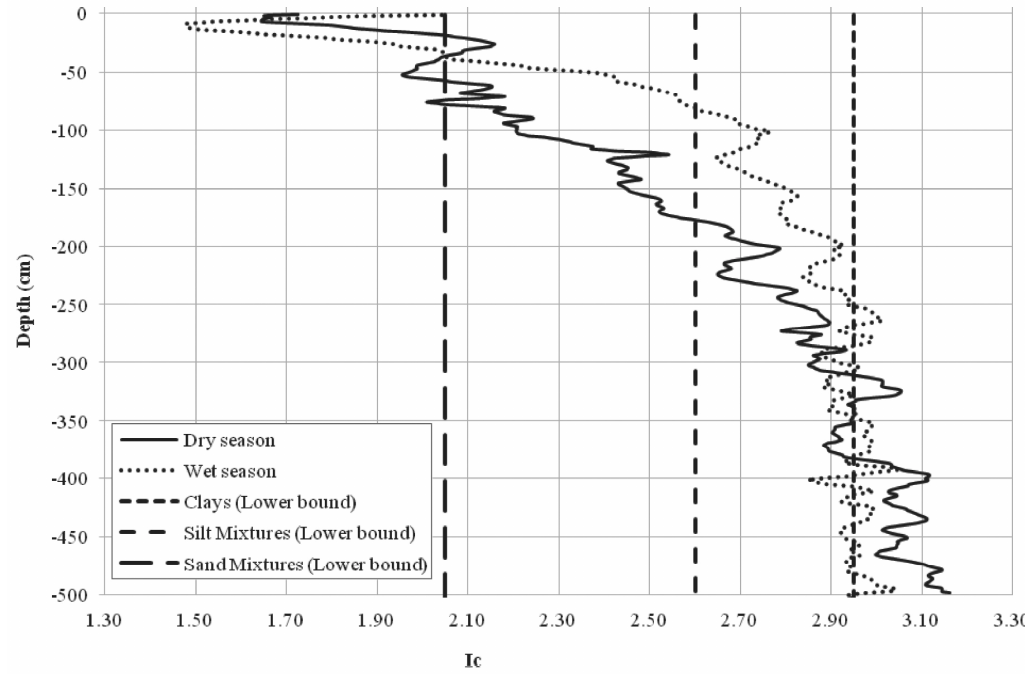
Figure 2. I c index from CPTu at Broni (PV, Italy) (Water table depths at 3.5 and 5 m during dry and wet seasons respectively) [5].